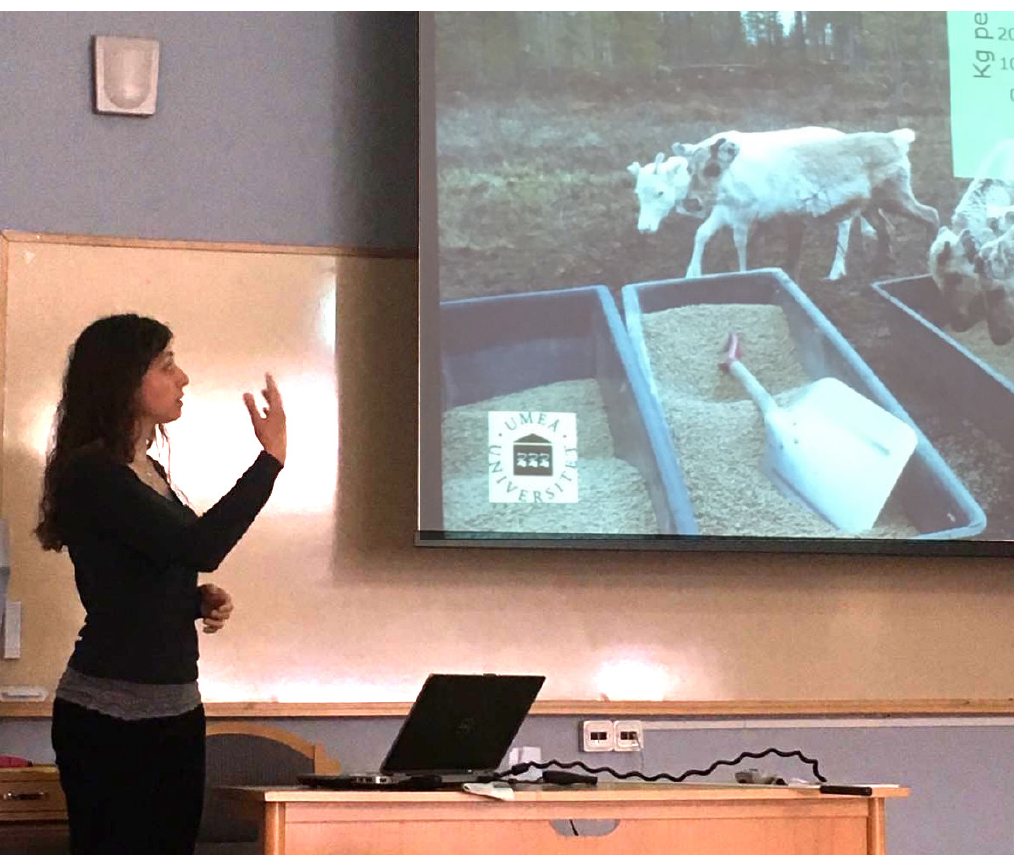
Fig. 2. Alessia Uboni during her presentation "Major declines in food resources challenge a centureies-old pastoral system" (Photo: Alice